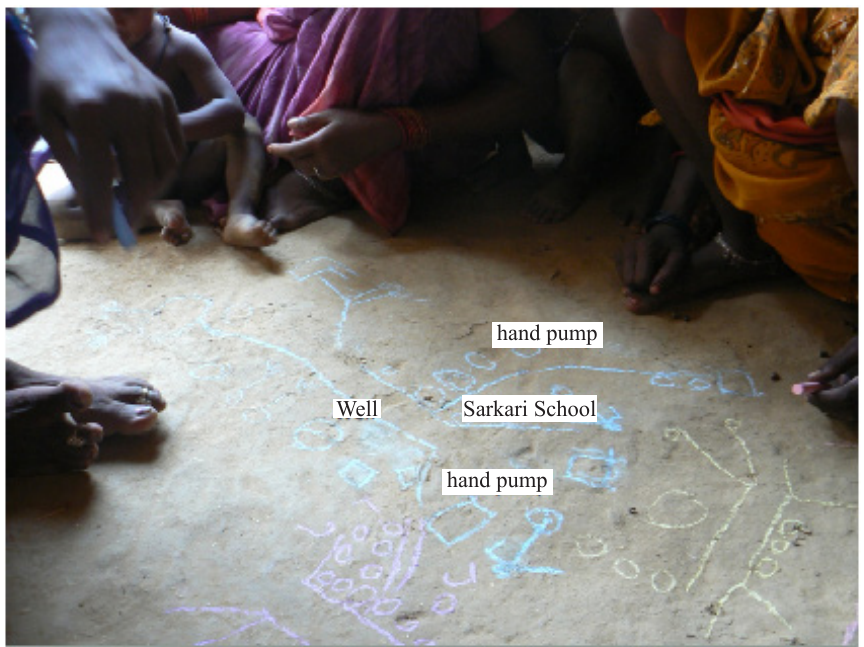
Figure 3: Map showing location of two hand pumps in the new mixed-caste neighborhood in northern Kaari. Each of the three mapmakers in this session had their own chalk color (May 2012).